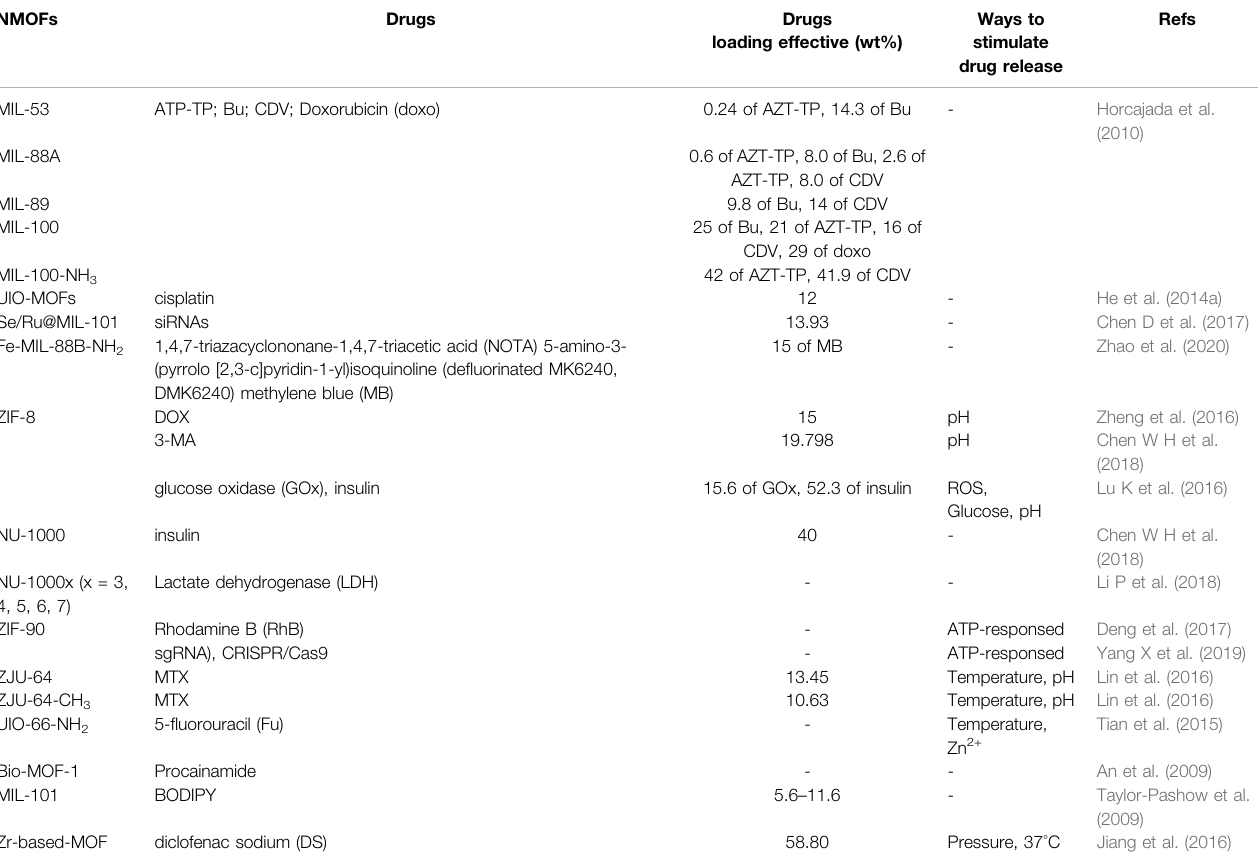
TABLE 1 | The drug release ability of various NMOFs as drug carriers.